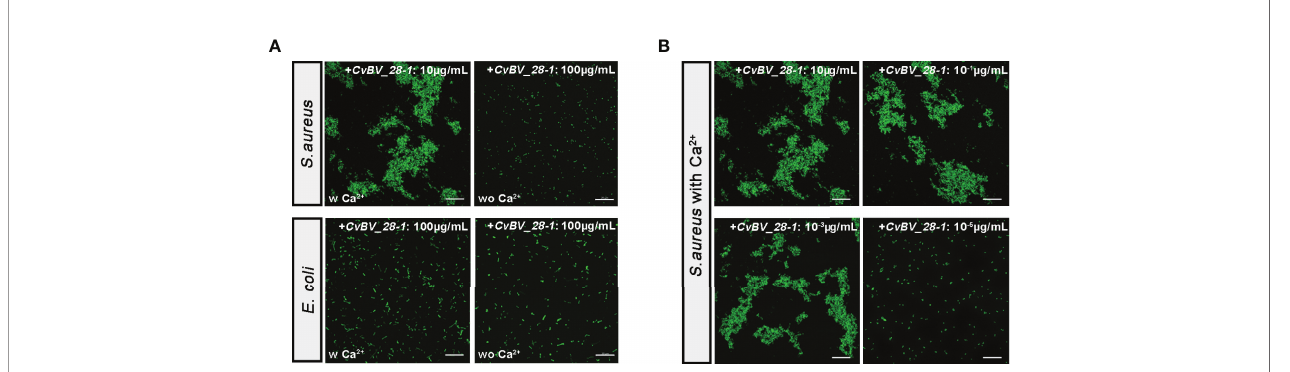
FIGURE 7 | CvBV_28-1 participates in the agglutination response to S. aureus . (A) Bacterial agglutination response assay of CvBV_28-1 in response to S. aureus and E. coli with or without Ca 2+ . The concentration of CvBV_28-1 used in each assay is shown in the images. Representative images from three independent replicates are displayed. Scale bars: 20 µm. (B) Bacterial agglutination response with different concentrations of CvBV_28-1 in response to S. aureus with Ca 2+ . The concentration of CvBV_28-1 used in each assay is shown in the images. Representative images from three independent replicates are displayed. Scale bars: 20 µm.